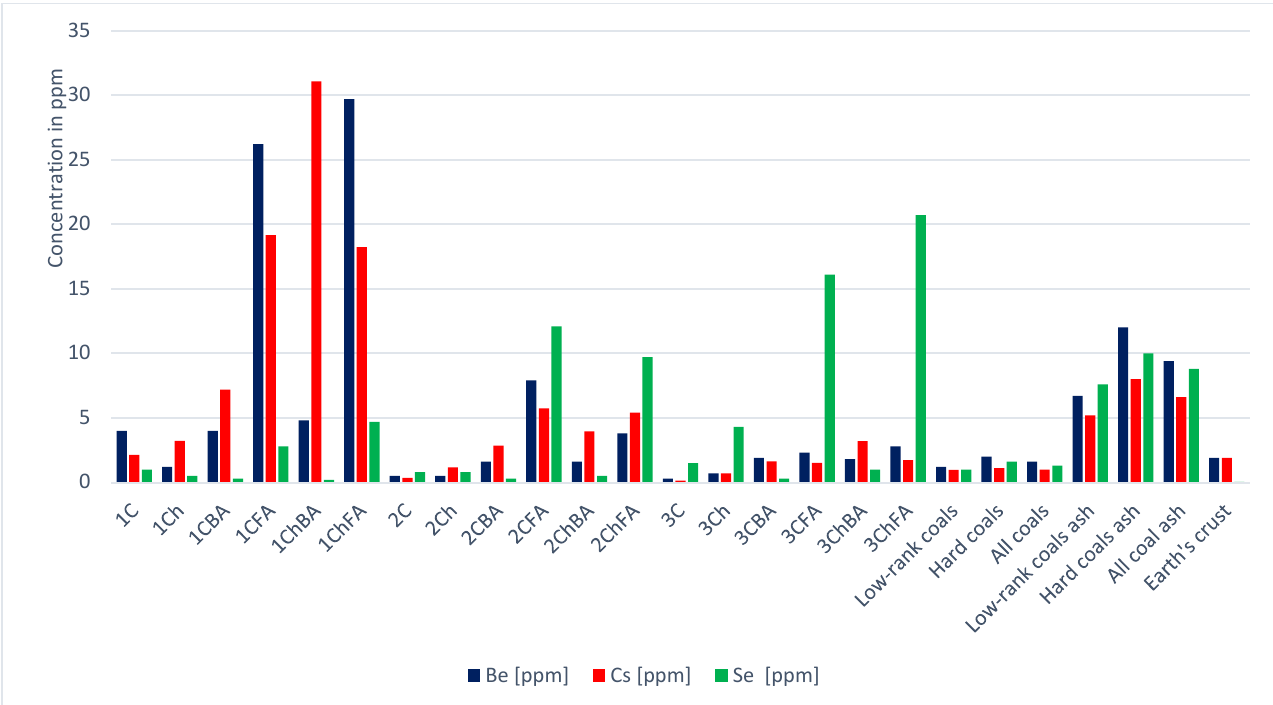
Figure 7. The Be, Cs, and Se content of coal, char, and ashes and their Clarke values [21].